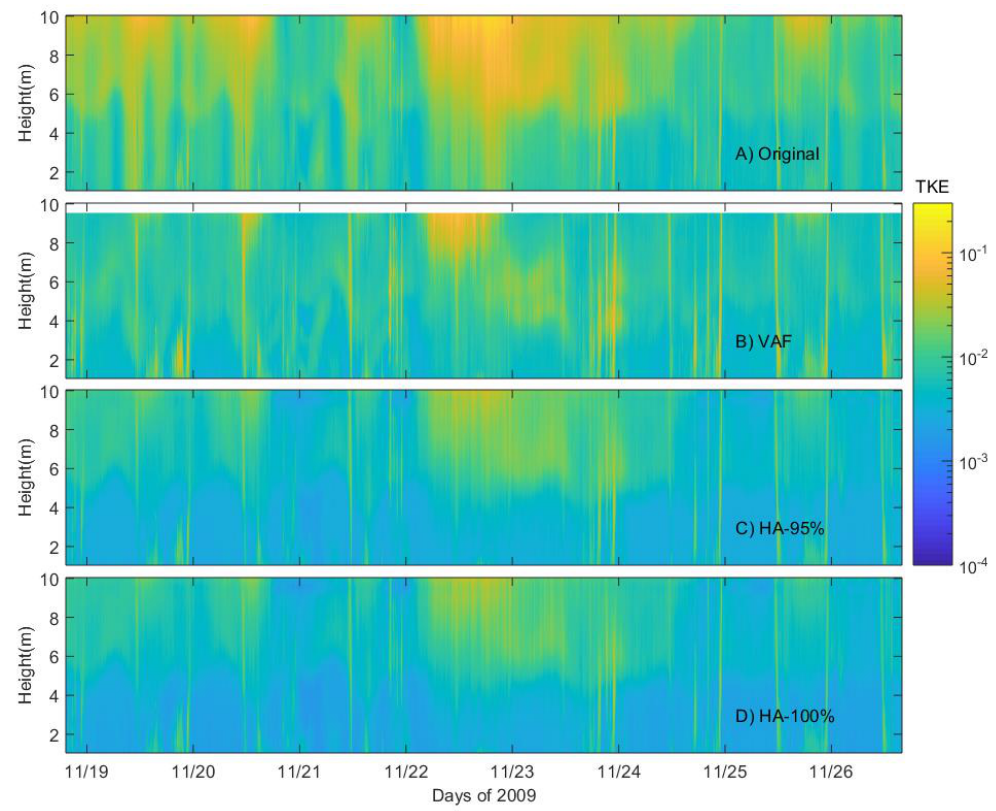
Figure 7. Turbulent Knetic Energy (TKE) estimated by ( A ) Original data, ( B ) VAF, ( C ) HA method with 95% wave energy removed, and ( D ) HA method with 100% wave energy removed.